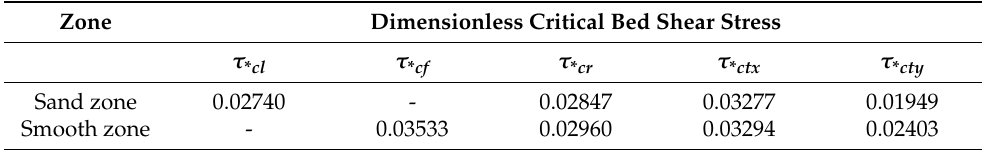
Table 5. Estimated dimensionless critical bed shear stress by different indirect